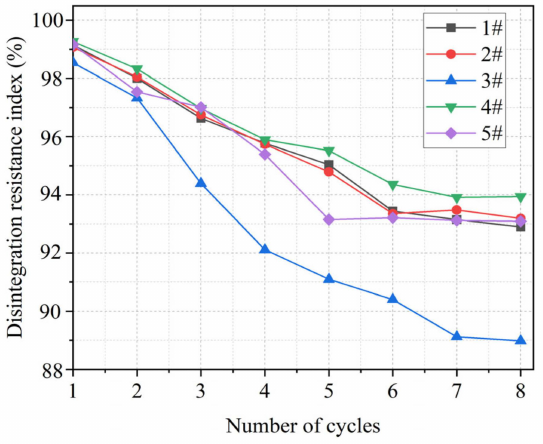
Figure 16. The relationship between disintegration index and the number of